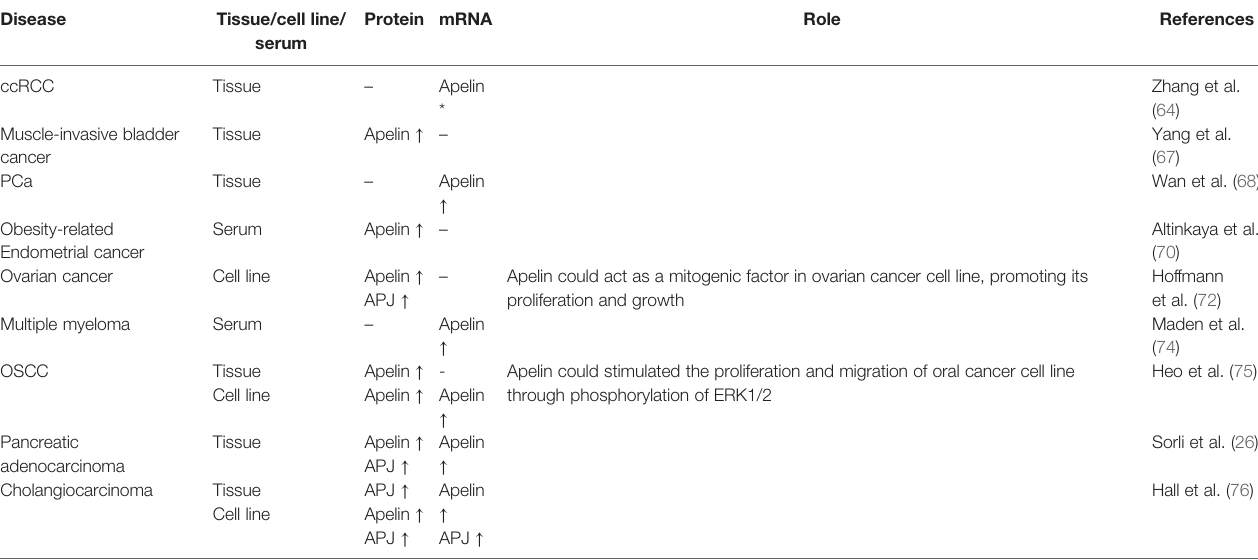
TABLE 4 | Expression and role of apelin/APJ signaling in genitourinary cancers, pelvic cancers and other types of cancers.